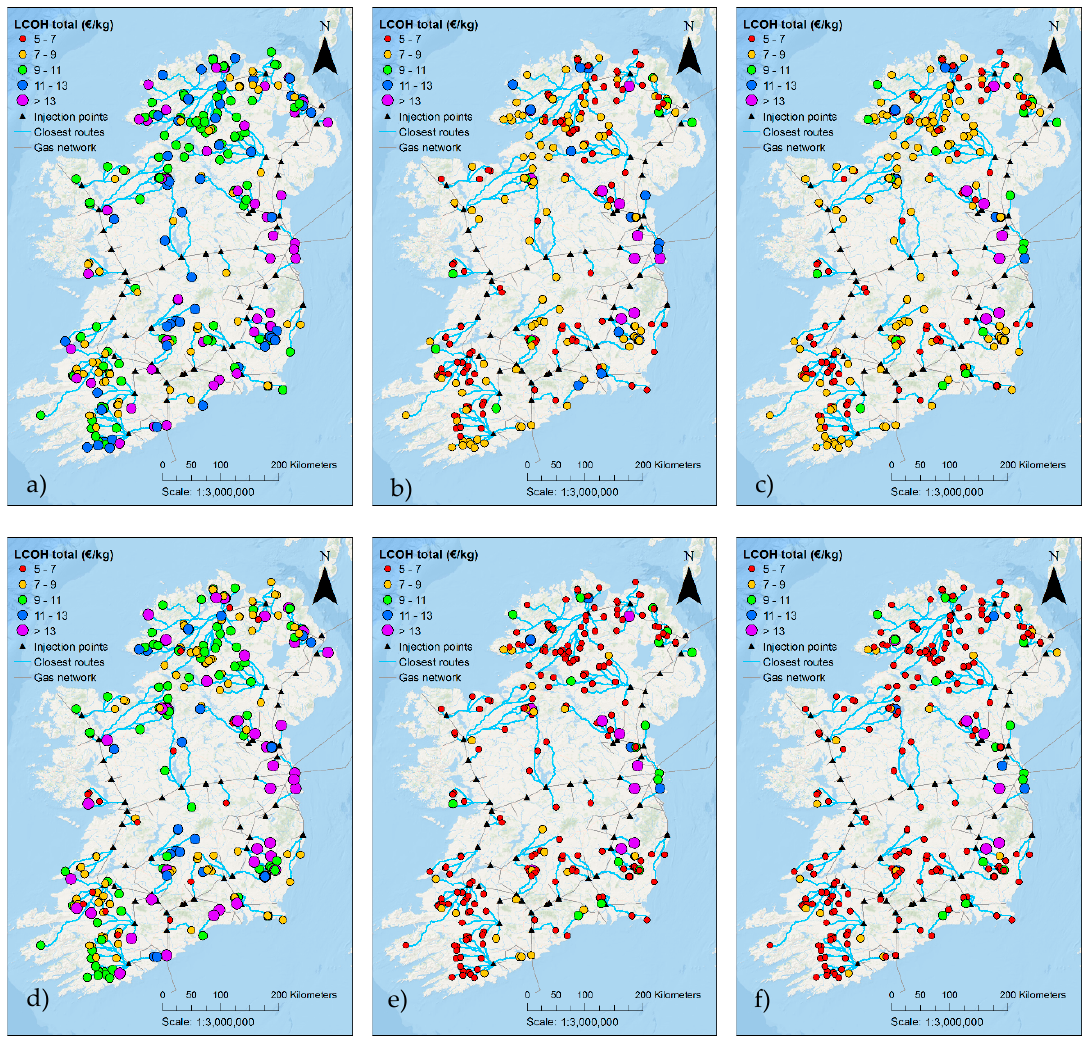
Figure 11. Future LCOH total of ( a ) curtailed wind operation at high electricity prices, ( b ) available wind operation at high electricity prices, ( c ) full capacity operation at high electricity prices, ( d ) curtailed wind operation at low electricity prices, ( e ) available wind operation at low electricity prices, and ( f ) full